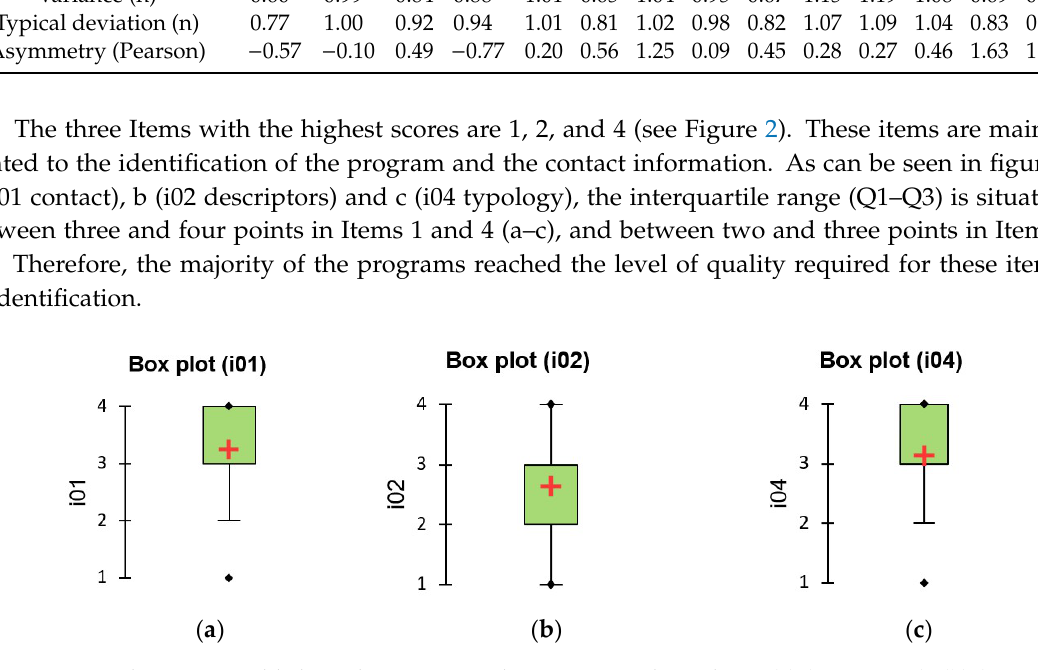
( c ) Figure 3. The most insufficient box plots: heritage, annexes, and assessment. 3.3. Correlations in the Assessment of the Quality of the Programs The table of Pearson correlations (see Table 7; Table 8) shows moderate to high correlation coefficients among all of the items, with the exception of Item 1, which has low correlations (between 0.17 and 0.25) with the other items. The rest maintain statistically significant coefficients as can be seen in the table of p-values. Thus, 87 of the 89 correlations have values p<0.05.